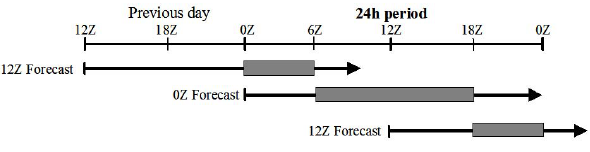
Fig. 3. Building a continuous time-series of atmospheric forcing from short-term